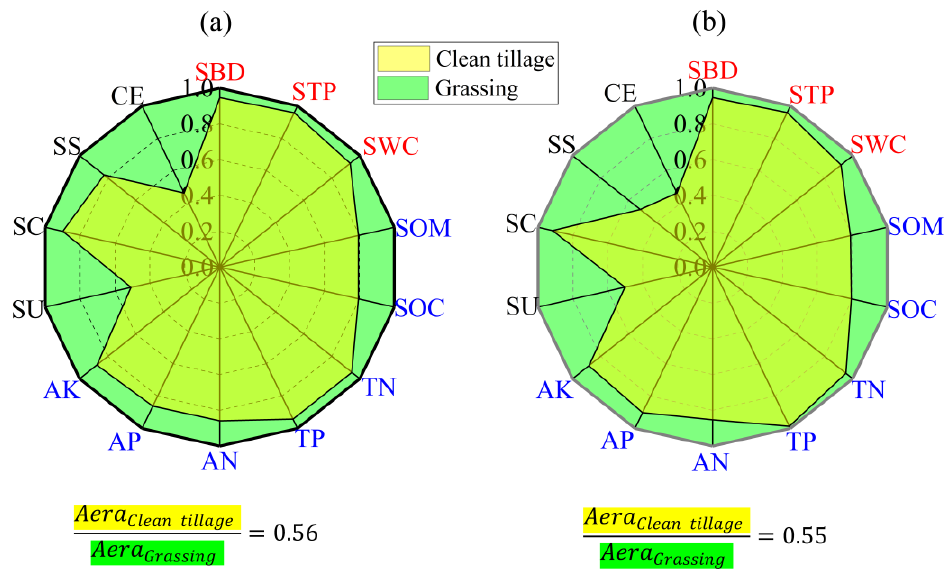
Figure 6. The soil quality index area (SQI-area) approach suitable for unifying evaluation of any number of soil parameters and to compare various SQI methods. ( a ) the whole China region; ( b ) the warm temperature semid-humid climate region. A decrease in the area on the radar plot between a non-degraded and a degraded soil is necessary. The ratio between the SQI area of non-degraded and degraded soils is independent of the number of parameters and the weightings involved in the calculation of the area. SBD: soil bulk density; STP: soil total porosity, SPH: soil pH; SWC: soil water content; SOM: soil organic matter; SOC: soil organic carbon; TN: soil total nitrogen; TP: soil